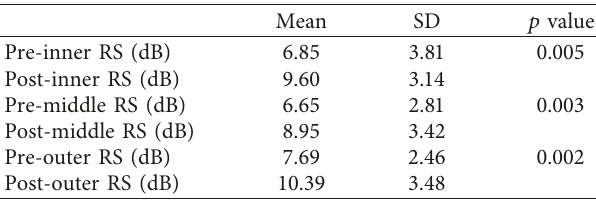
Table 2: The preoperative and postoperative values of the inner, middle, and outer rings of the retinal sensitivity at microperimetry in Group B.